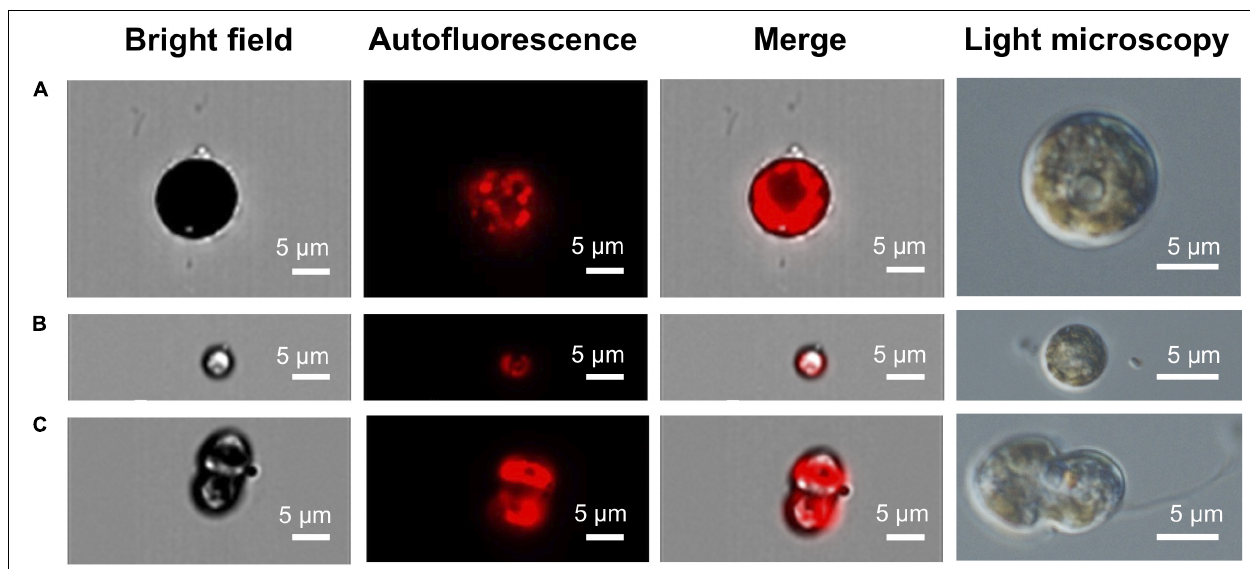
FIGURE 4 | IFC autofluorescence and light microscopy images of in vivo cultures of free living C. tuberculata Symbiodiniaceae. (A) Bigger coccoid stage with a reticulated chloroplast. (B) Small coccoid stage with a parietal chloroplast. (C) Motile flagellated